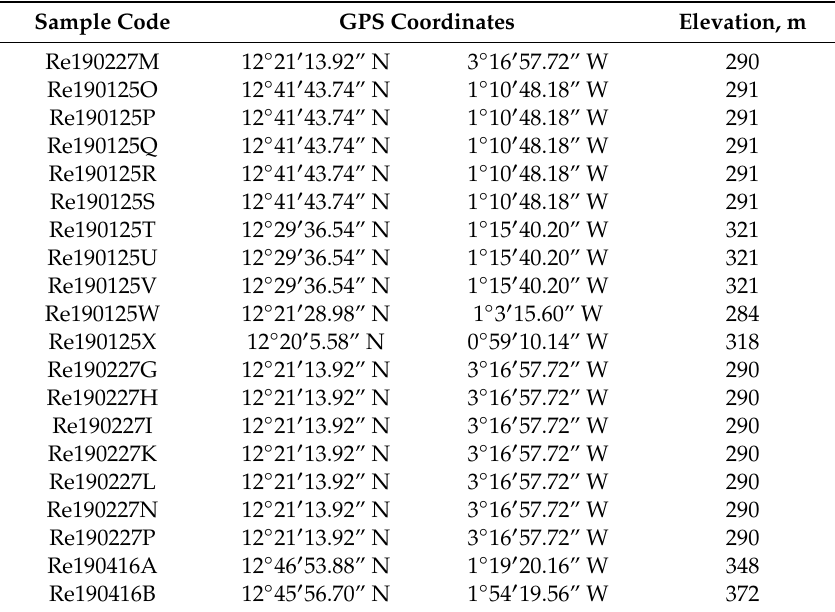
Figure 3. Locations where B. dalzielii oleogum resin samples were collected. Table 2. Geographical collection locations of Boswellia dalzielii oleogum resins.